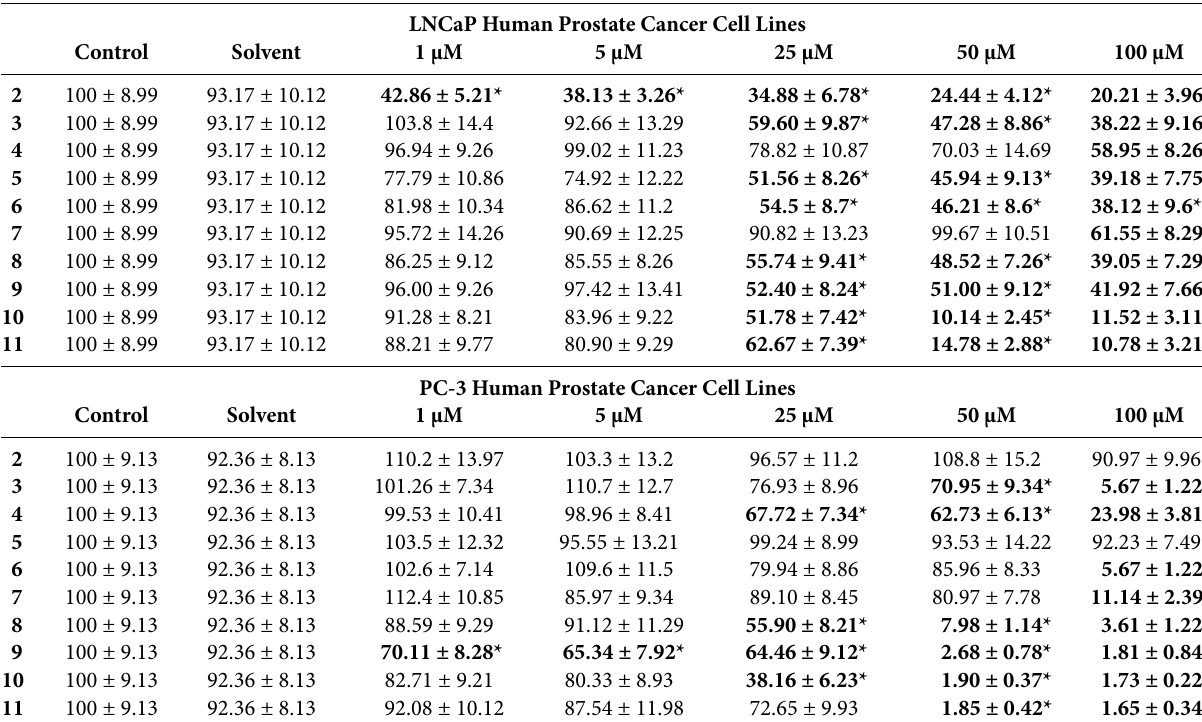
Table 2. Cell Viability (in %) of compounds 2 – 11 against cancer cell lines ( p * <